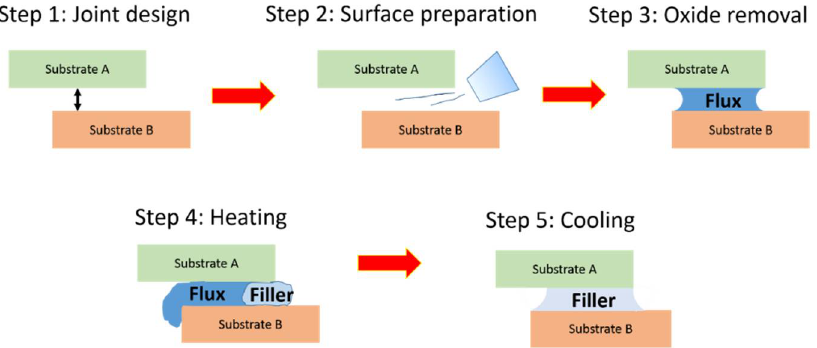
Figure 1. Various steps of the brazing process.